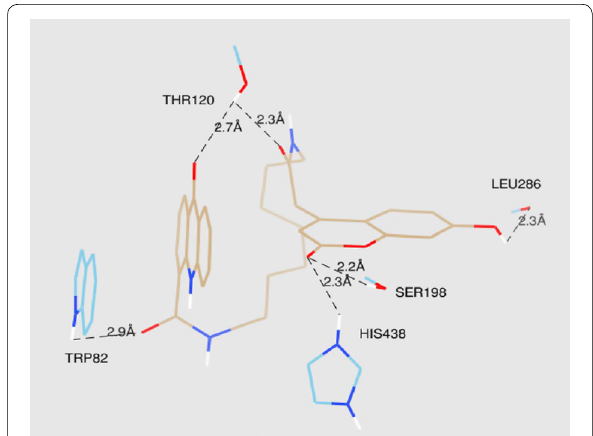
Fig. 48 Top-score docking pose of derivative C45b depicting its putative hydrogen bonds formed with amino acid residues in the active-site gorge of hBuChE [54]